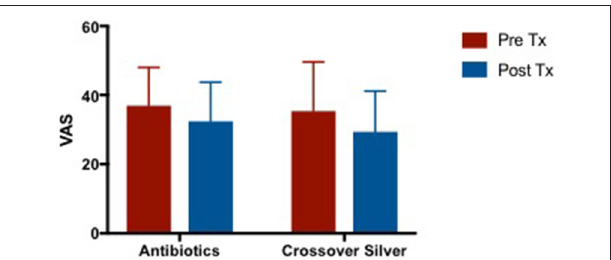
FIGURE 5 | Bar graph comparing VAS scores of patients following failed culture sensitive oral antibiotics and crossed-over to CS treatment. VAS, Visual Analog Scale; CS. Colloidal